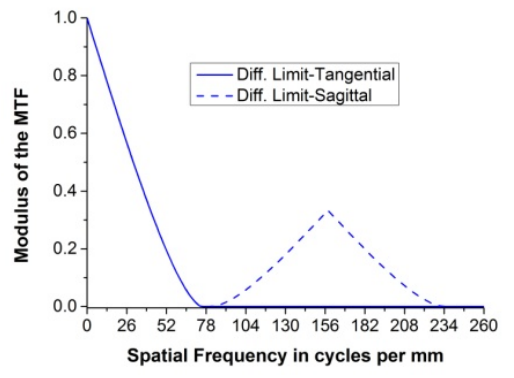
Figure 5. The MTF of the initial configuration.